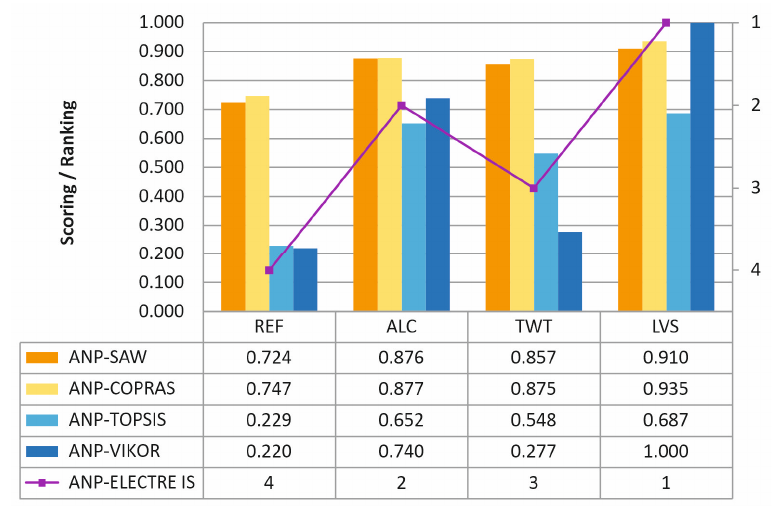
Figure 5. Validation of ranking results using other MCDM methods.